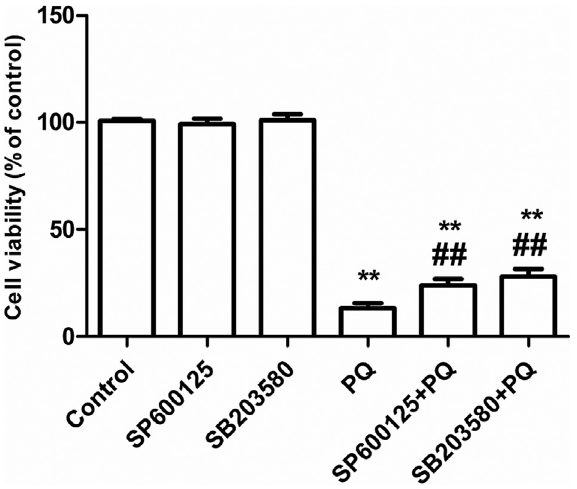
Figure 1 - Effect of blocking MAPKs pathway on PQ-induced cytoto- xicity. ** P < 0.01 vs control group; ## P < 0.01 vs PQ alone group.